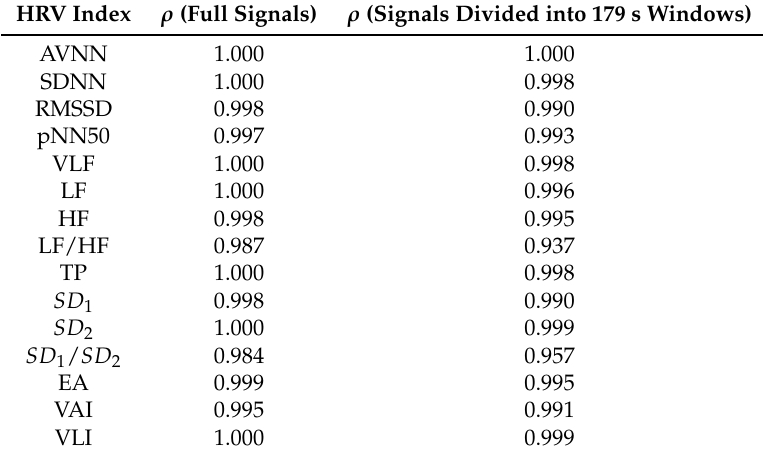
Table 7. Pearson’s linear correlation coefficient of HRV indices obtained on ECG and GCG signals. HRV Index ρ (Full Signals) ρ (Signals Divided into 179 s Windows) AVNN 1.000 1.000 SDNN 1.000 0.998 RMSSD 0.998 0.990 pNN50 0.997 0.993 VLF 1.000 0.998 LF 1.000 0.996 HF 0.998 0.995 LF/HF 0.937 0.990 1.000 0.999 0.957 0.999 0.995 0.995 0.991 1.000